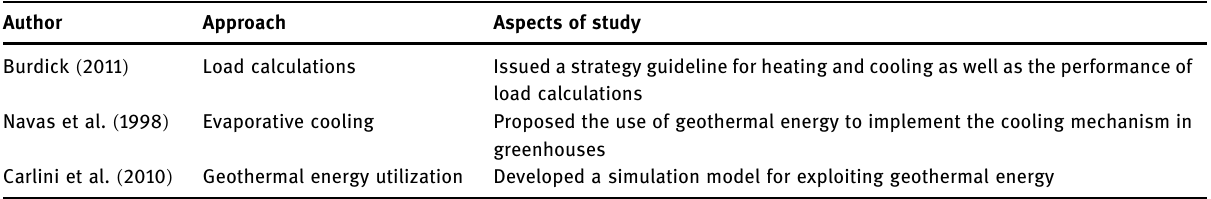
Table 3: Reviewed articles, approaches, and parameters studied